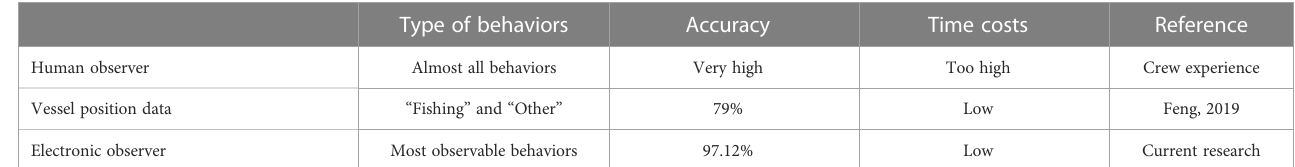
TABLE 6 Comparison of three methods of ship behavior recognition.